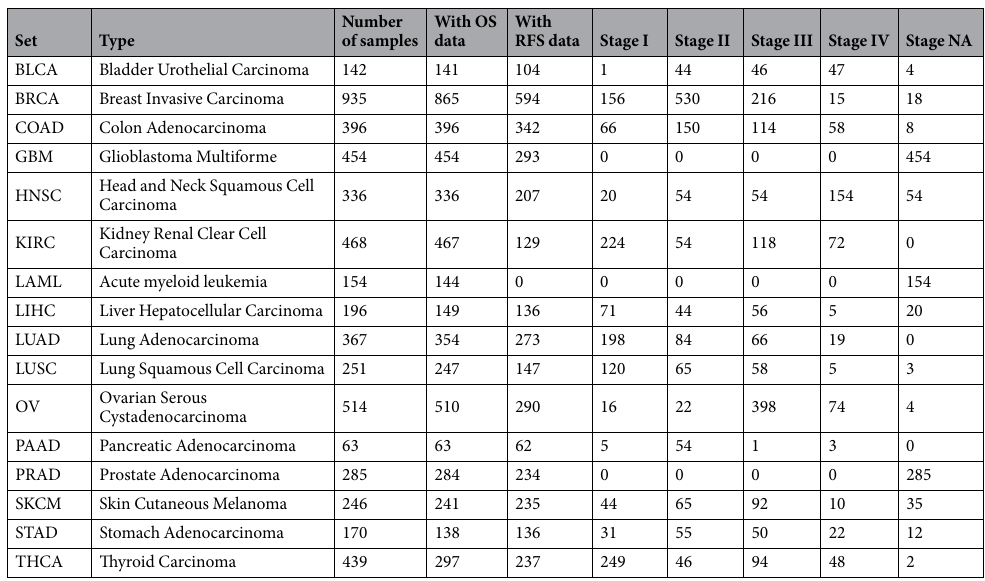
Table 1. TCGA samples. Description of the 16 datasets downloaded from the TCGA and the related